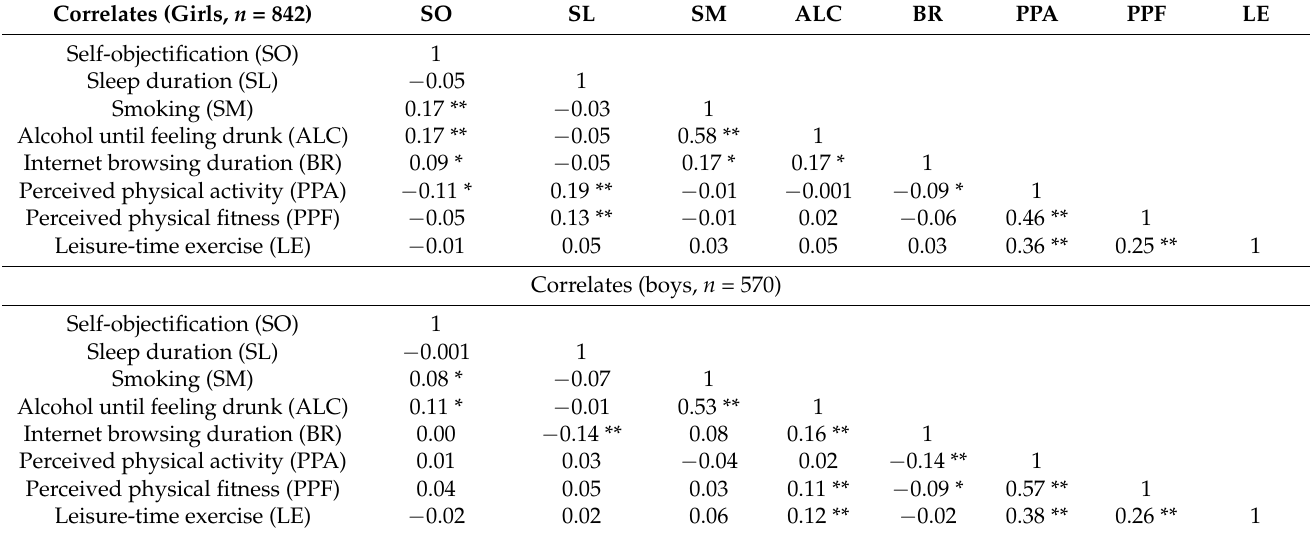
Table 5. Associations between self-objectification, harmful lifestyle habits, sleep duration, and physical activity-related behaviors in adolescent boys and girls ( n =